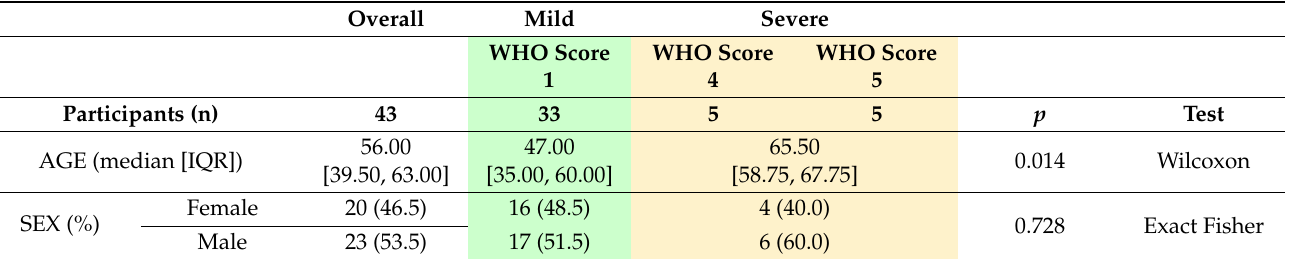
Table 1. Cohort description—age and gender. This table summarises the demographic characteristics of the 43 patients selected for the analysis: Age and Sex overall and stratified by the WHO Score, p -value and the corresponding statistical tests are reported. Overall Mild